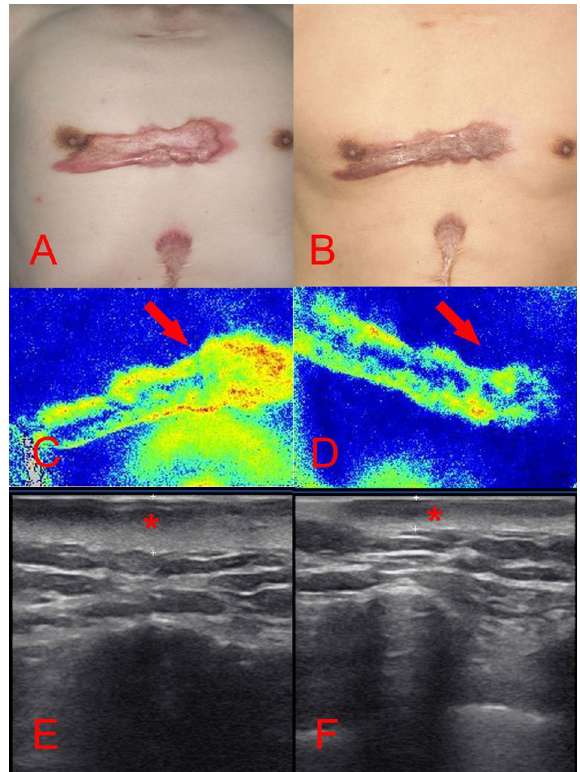
Figure 5. A 66-years-old man [case 21] sustained a keloid on his chest caused by acne over 10 years period ( A ); after a 6 months follow-up and 2 treatments using intralesional 1470 nm bare-fibre diode laser ( B ); the scar blood perfusion showed 98.79 Units before the treatment ( C ), which decreased to 38.92% after two sessions of laser treatment ( D ); the average thickness of the scar was 0.79 cm ( E ), resulting in a decreased of 45.57% after the laser treatment ( F ).